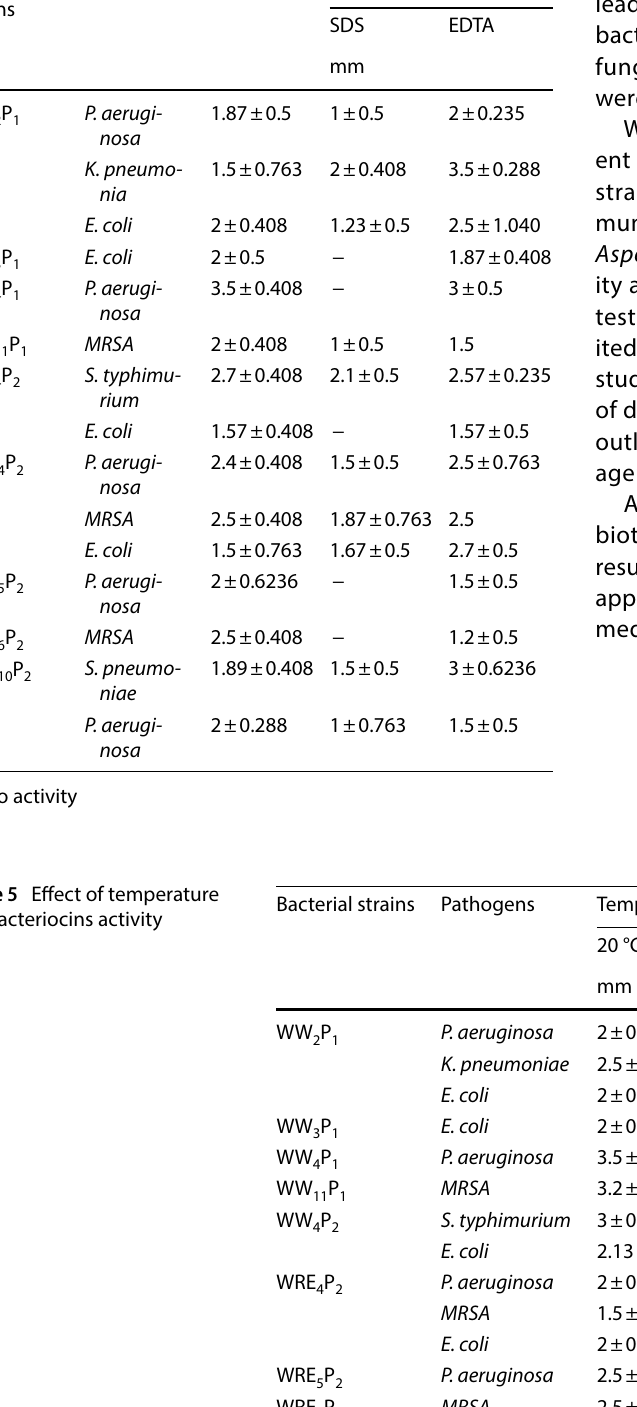
Table 4 Effect of surfactants on bacteriocins activity